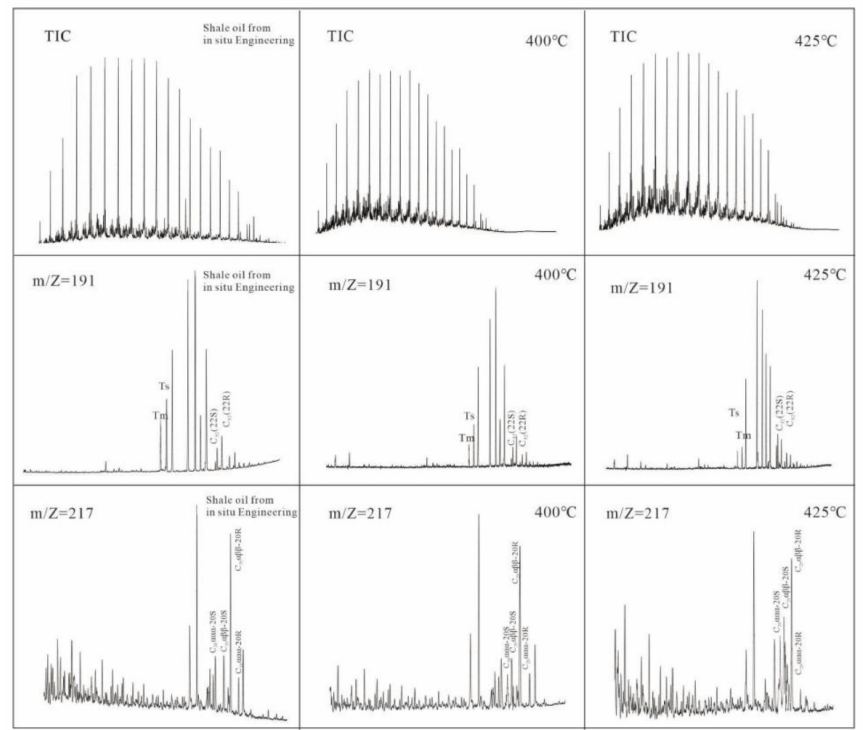
Figure 11. GC-MS analysis of field oil shale pyrolysis oil and 400–425 ◦ C simulated pyrolysis oil